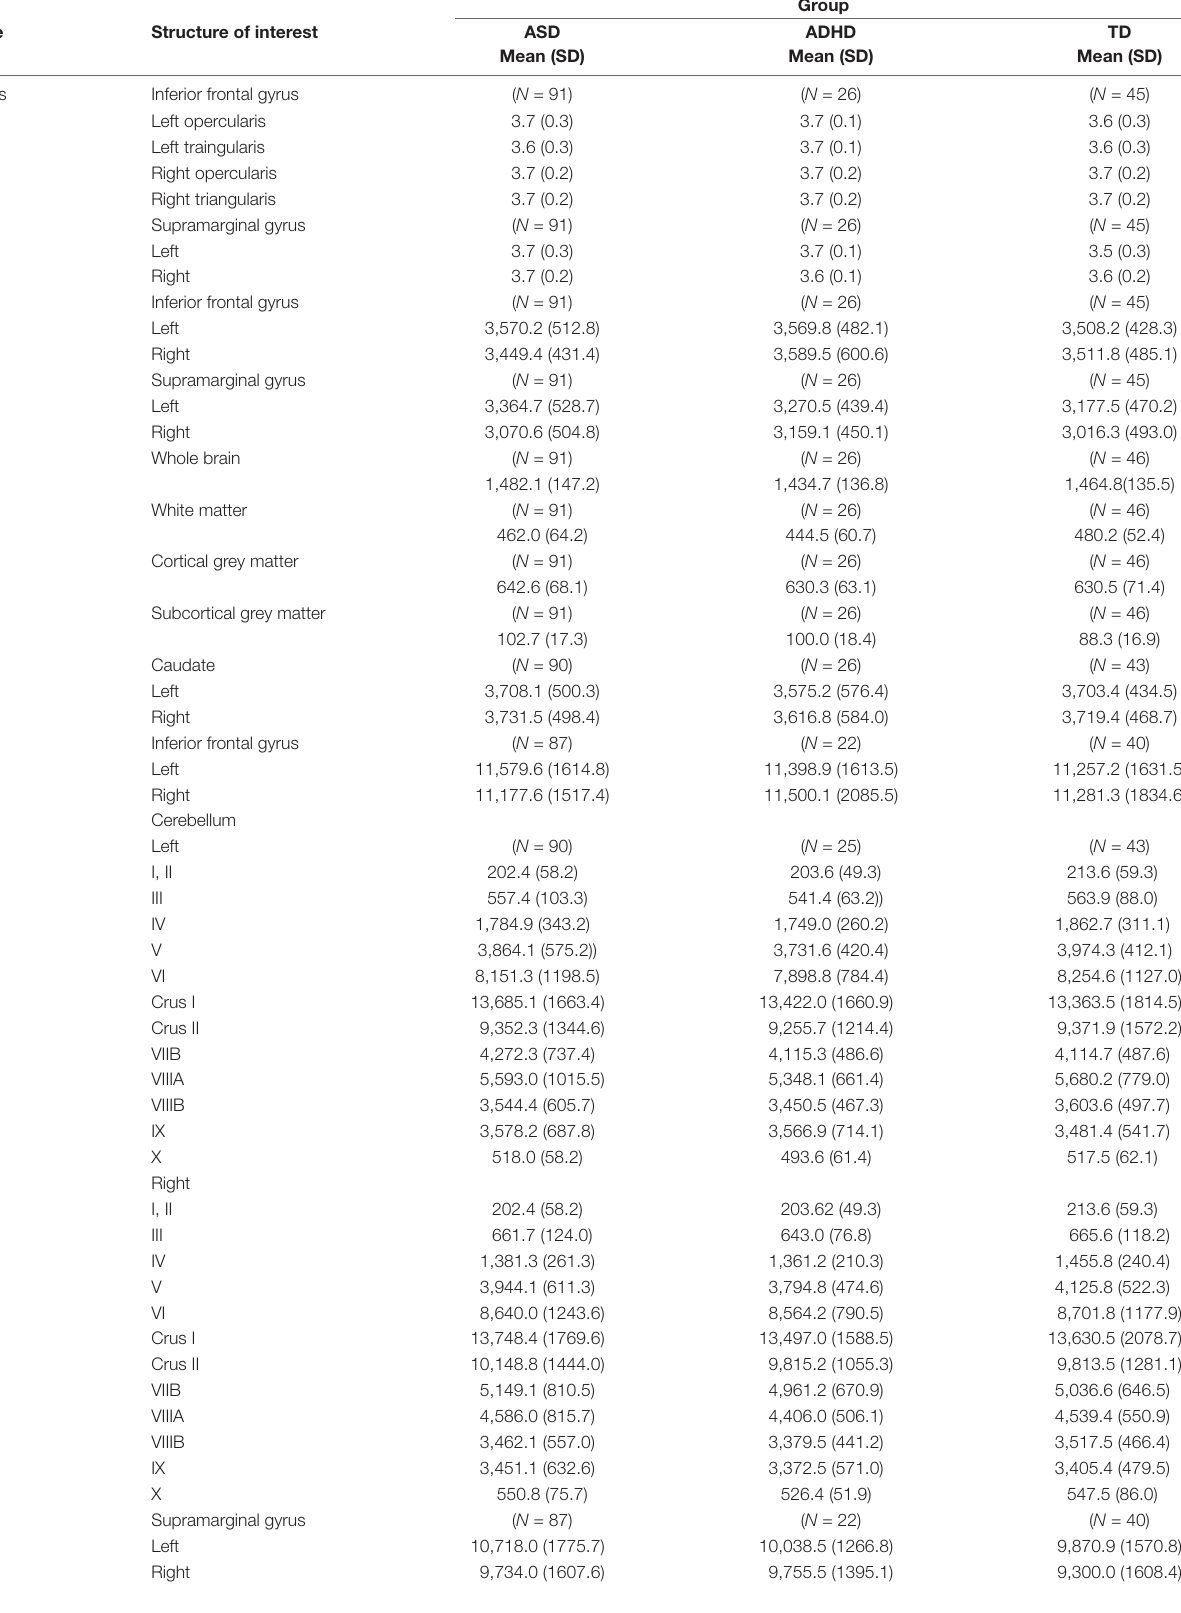
TABLE 3 | Thickness (mm), area (mm 2 ), and volume (mm 3 ) of structures of interest by diagnostic